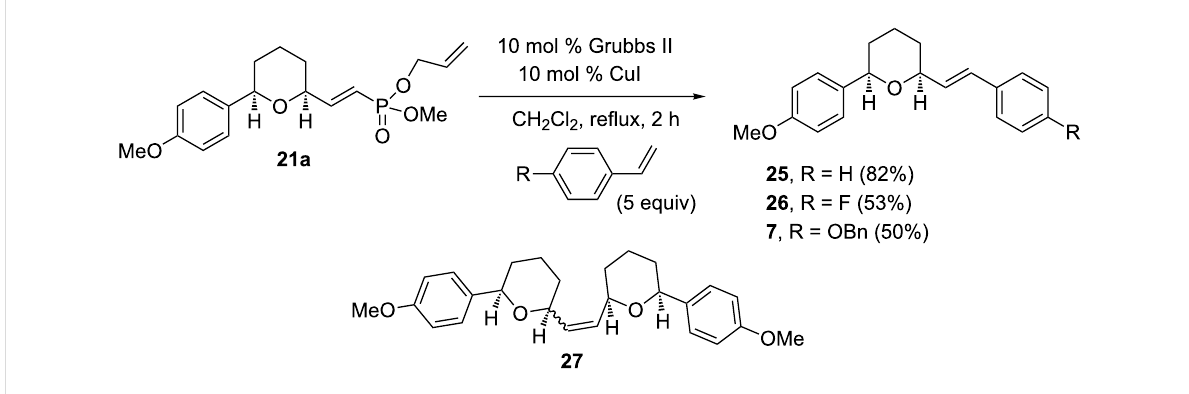
Scheme 7: Relay cross metathesis of mono-allyl vinylphosphonates with